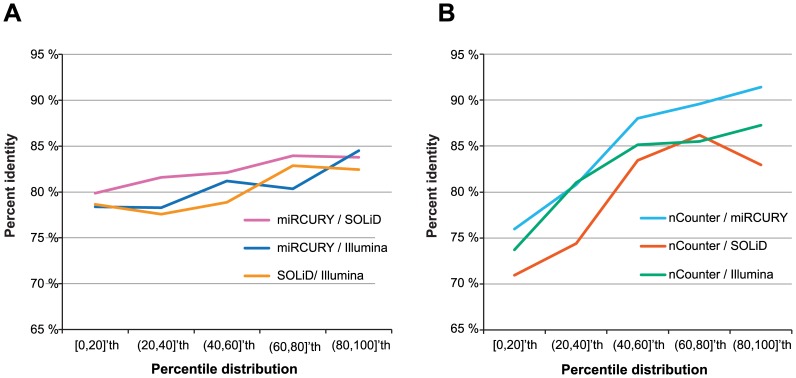
Platform accuracy in relation to miRNA concentration.(A) The percent identity in fold change across the percentile distribution of miRNAs for all platform combinations without the nCounter platform. Here, an even accuracy is seen across the full range of miRNA concentration. (B) The same data for platform combinations involving the nCounter platform reveal a large drop in accuracy when the miRNA abundance is low.